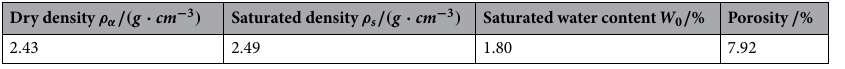
Table 1. Initial physical parameters of sandstone.